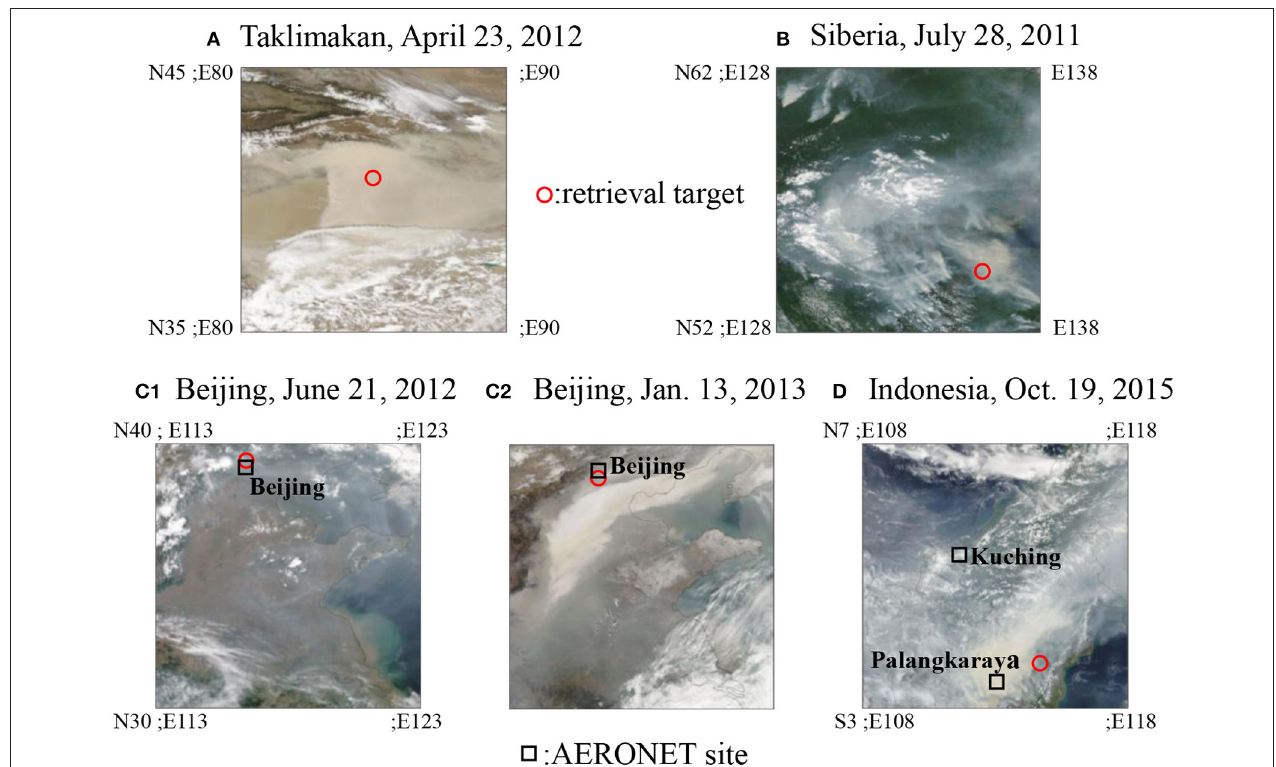
FIGURE 4 | True color composite images consisting of Aqua/MODIS bands 1, 4, and 3 (MYD02 Collection 6) for RGB color space over (A) the Taklimakan Desert, (B) Siberia, (C1,C2) Beijing, and (D) Indonesia. The small red circles denote the targets for aerosol retrieval case studies and the small black squares in (C1,C2,D) indicate the NASA/AERONET